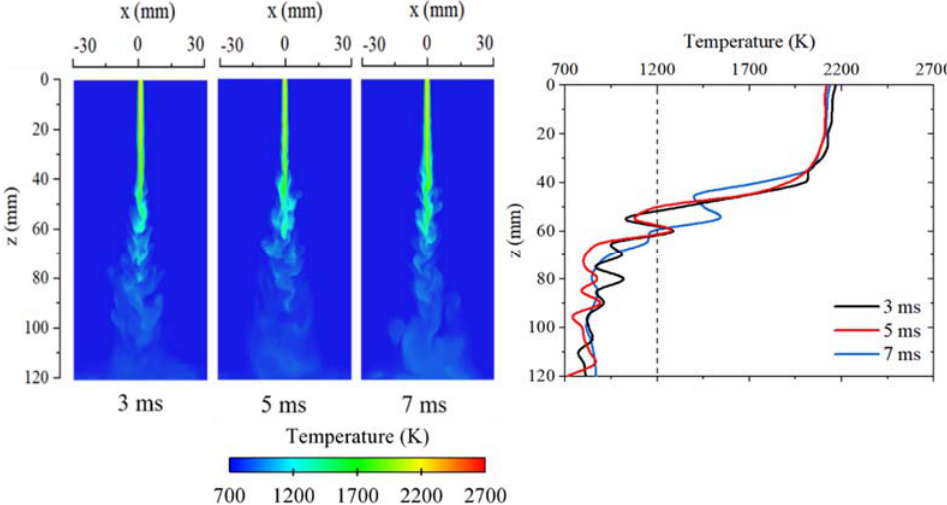
Figure 6. Distribution of jet temperature and centerline temperature traces for different spark timings at 3 ms after the hot jet appeared.